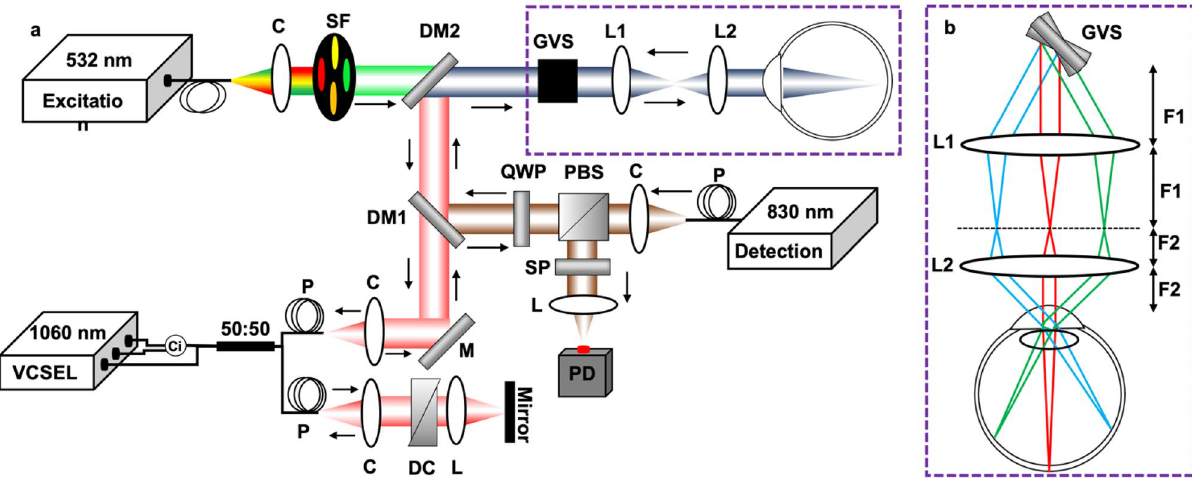
Figure 1. Retina imaging setup ( a ) Simplified schematic of the developed system. C: Collimator, Ci: Circulator, DC: Dispersion compensation, DM: Dichroic mirror, GVS: Galvo Scanner, L: Lens, P: Polarization controller, PBS: Polarized beam splitter, PD: Photodiode. QWP: Quarter wave plate, SF: Spectral Filter, SP: Short pass filter, VCSEL: Vertical Cavity Surface Emitting Laser. ( b ) Imaging optics arrangement of the telecentric pair for retina imaging. The distances between the elements are as F1 = 50 mm, F2 = 30